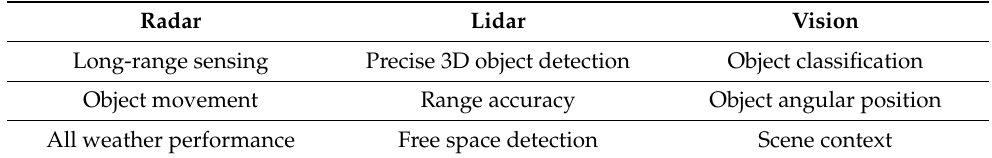
Table 1. Main features of radar, lidar, and vision